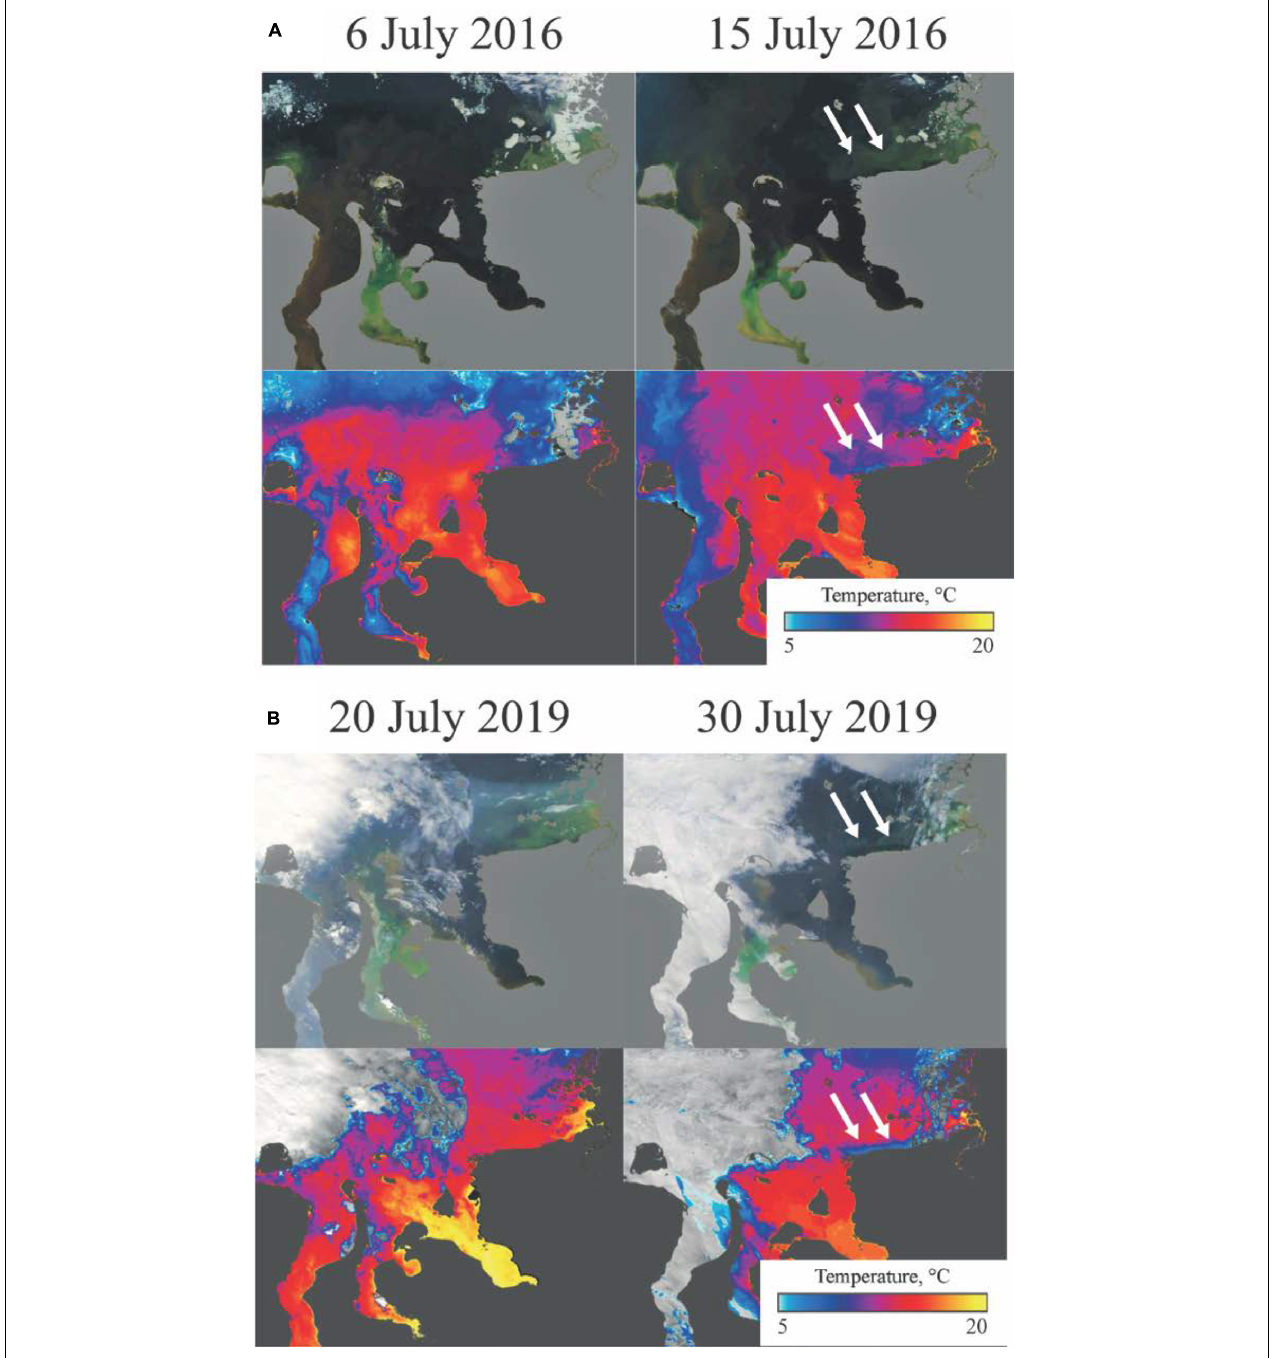
FIGURE 9 | MODIS optical imagery (top panels) and sea surface temperature (bottom panels) in the central part of the Kara Sea on July 6 and July 15, 2016 (A) , on July 20 and July 30, 2019 (B) . White arrows indicate the location of cold (at thermal images) and turbid (at optical images) surface water along the coast, which manifest upwelling along the Taymyr